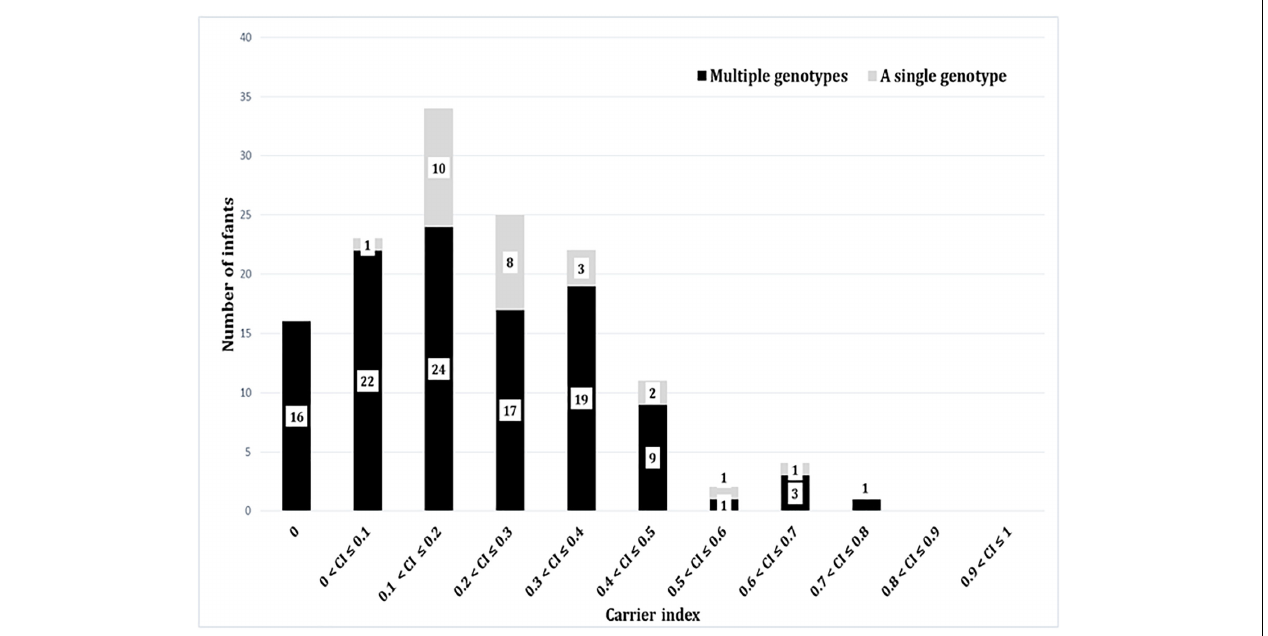
FIGURE 4 | The carrier indices for 137 infants followed up longitudinally every 2 weeks for the first year of life. The carrier index is defined as the number of S. aureus positive swabs divided by the total number of NP swabs collected per infant during the study period. The gray bars represent number of infants with specified carrier index who carried a single genotype in all positive swabs, whilst dark bars represent number of infants who carried multiple different genotypes at different time points. For example, 34 infants had a carrier index of greater than 0.1 and less than or equal to 0.2. Of these 34 infants, 10 infants carried a single genotype over the period of study, whilst 24 carried multiple